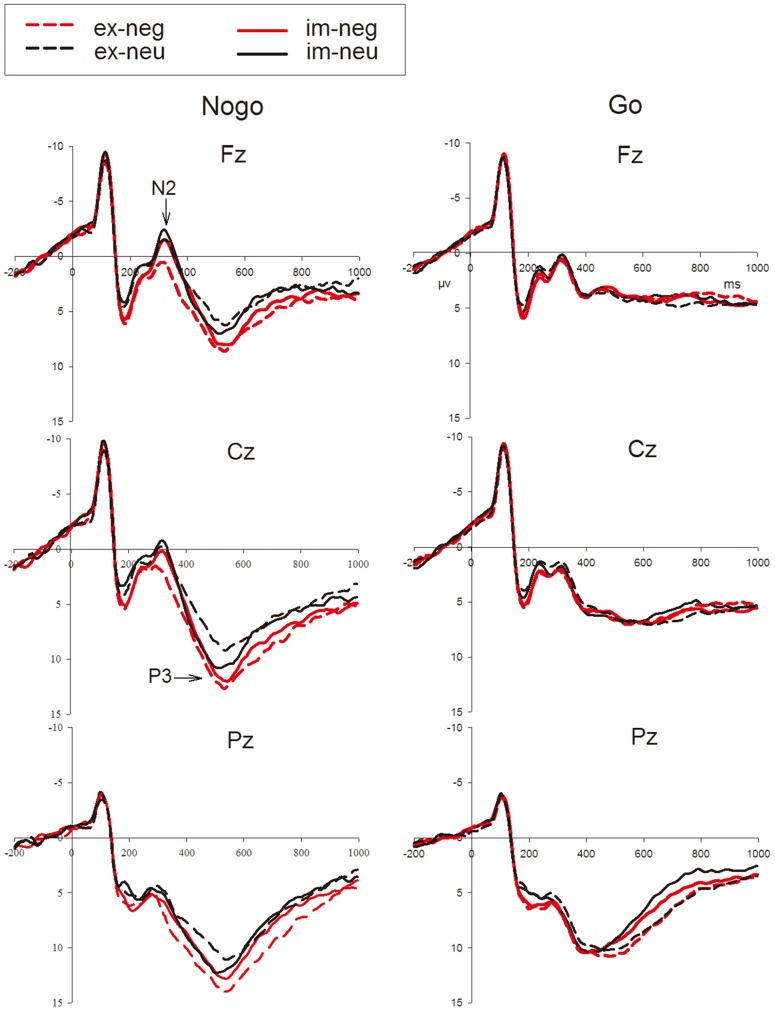
Grand averages evoked by negative (red lines) and neutral (black lines) stimuli in Nogo (left column) and Go trials (right column) under implicit (solid lines) and explicit conditions (dash lines) at Fz, Cz and Pz sites (im: implicit; ex: explicit; neg: negative; neu: neutral).